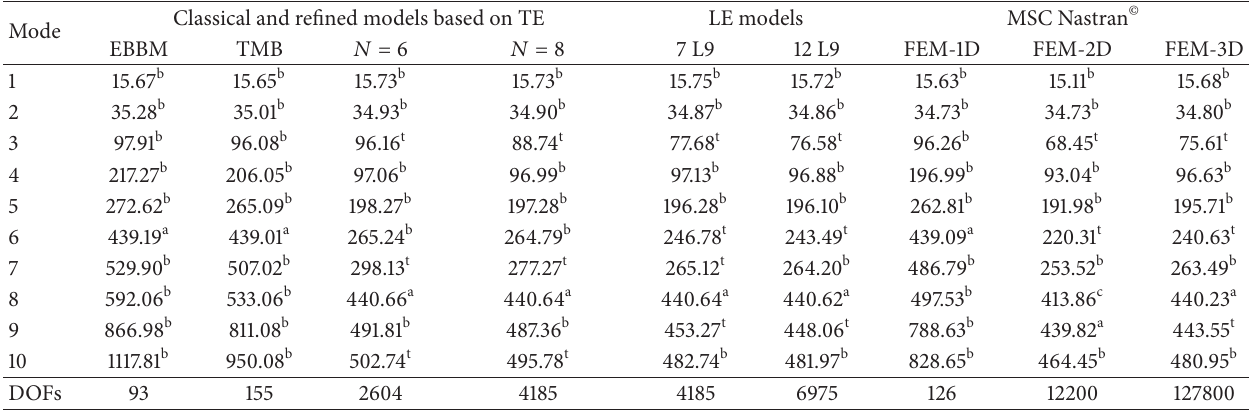
Table 4: First 10 natural frequencies (Hz) for the I-shaped